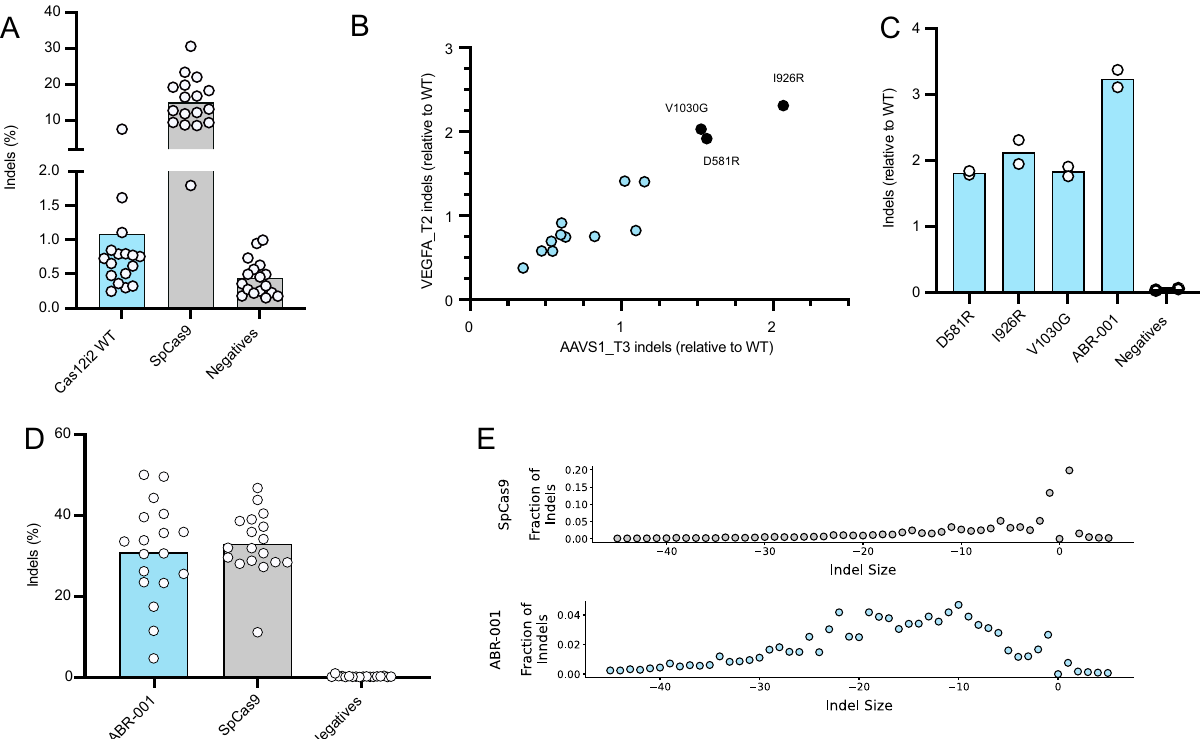
Fig. 1 Semi-rational engineering of Cas12i2 to improve indel activity in mammalian cells. a Indel activity of wild-type Cas12i2 (WT) and SpCas9 expressed from a EFS promoter in HEK293T cells at 18 genomic target sites. Each circle represents a single target site, averaged from n = 2 replicates. Each bar represents the mean across 18 targets (ABR-001 in blue, SpCas9 and negative in gray). b Indel activity (relative to WT) of 14 single-substitution variants measured in HEK293T cells at two genomic target sites. Each circle represents indels for a single variant ( n = 1). Black circles indicate the three mutations present in ABR-001. c Indel activity (relative to WT) of top three single substitutions and their combination variant, ABR-001. Bars represent mean of 2 targets and each circle represents n = 2 replicates at a single target site. d Indel activity of ABR-001 and SpCas9 expressed from a CMV promoter in HEK293T cells at 18 genomic target sites. Each circle represents a single target site, averaged from n = 2 replicates. Each bar represents the mean across 18 targets (ABR-001 in blue, SpCas9 and negative in gray). e. Indel size distribution comparison between SpCas9 and ABR-001 after genome editing of 18 target sites in HEK293T cells. The fraction of indels is analyzed by aggregating all indel reads, binning the reads by indel size (a minus value is deletion, a positive value is insertion). Circles represent average fraction of indels, binned by indel size, of 18 targets with n = 2 replicates (ABR-001 in blue, SpCas9 in gray). Source Data are provided as a Source Data fi